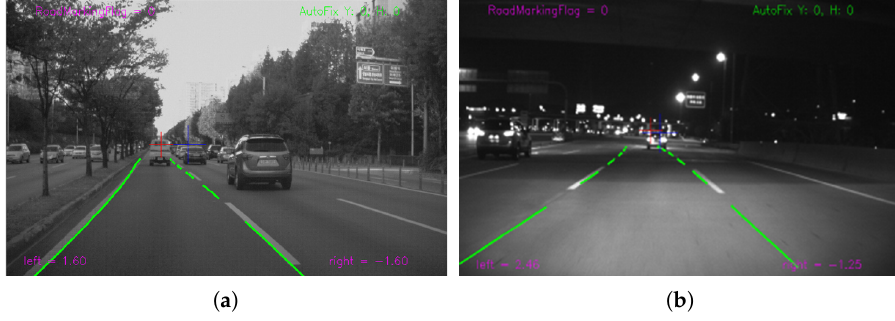
Figure 5. Line fitting results: ( a ) daytime result, and ( b ) night result.